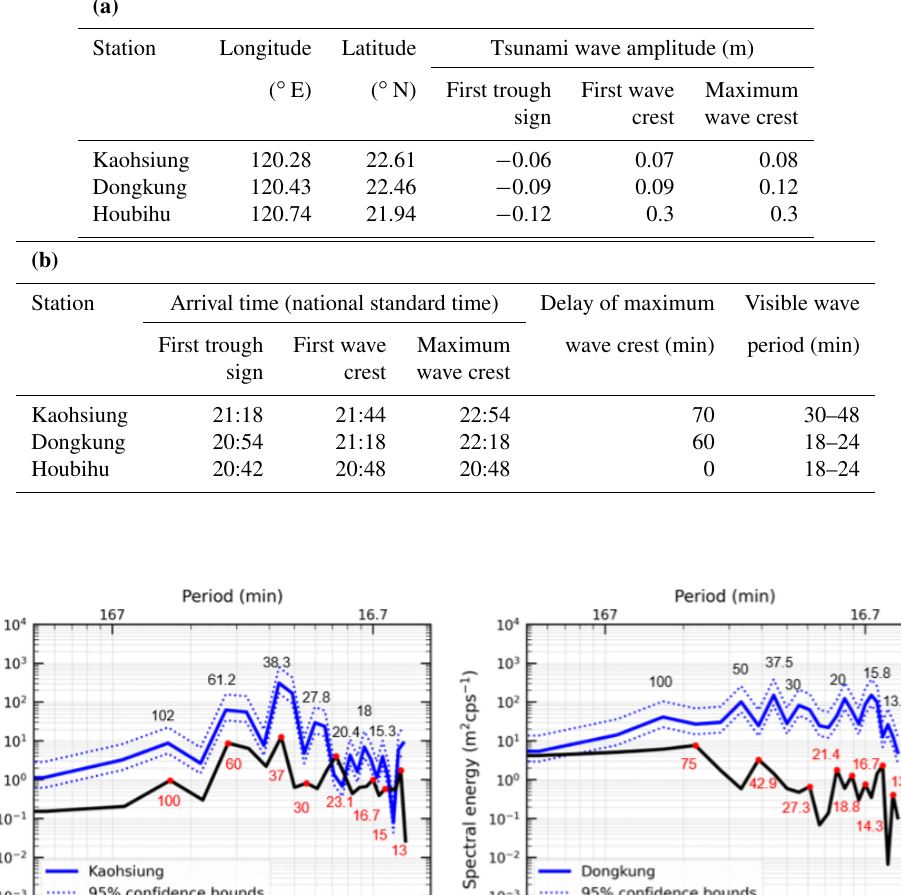
Nat. Hazards Earth Syst. Sci., 23, 447–479,